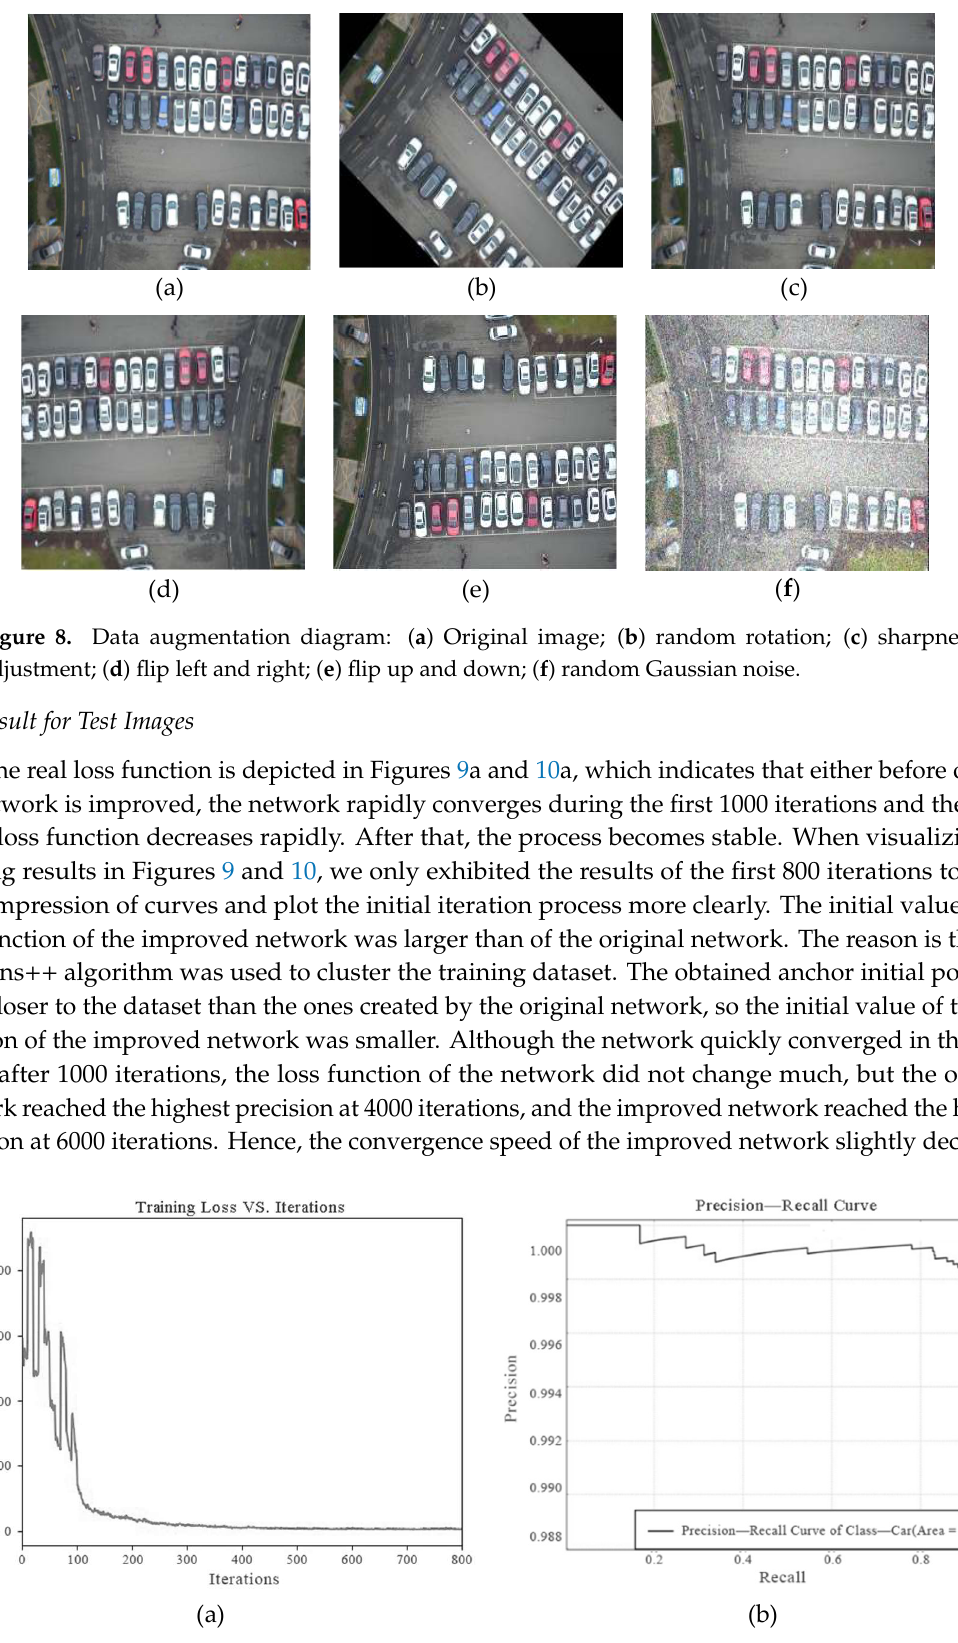
Figure 9. The training and test results of the original YOLOv3: ( a ) The loss curve for network training; ( b ) the test PR (Precision Recall) curve for the network.